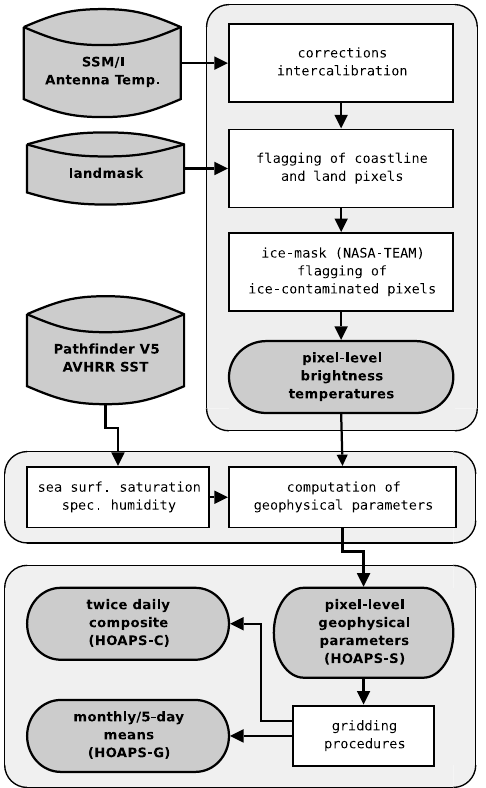
Figure 1. Flow chart for the data processing chain in HOAPS-3 from SSM / I antenna temperatures to geophysical